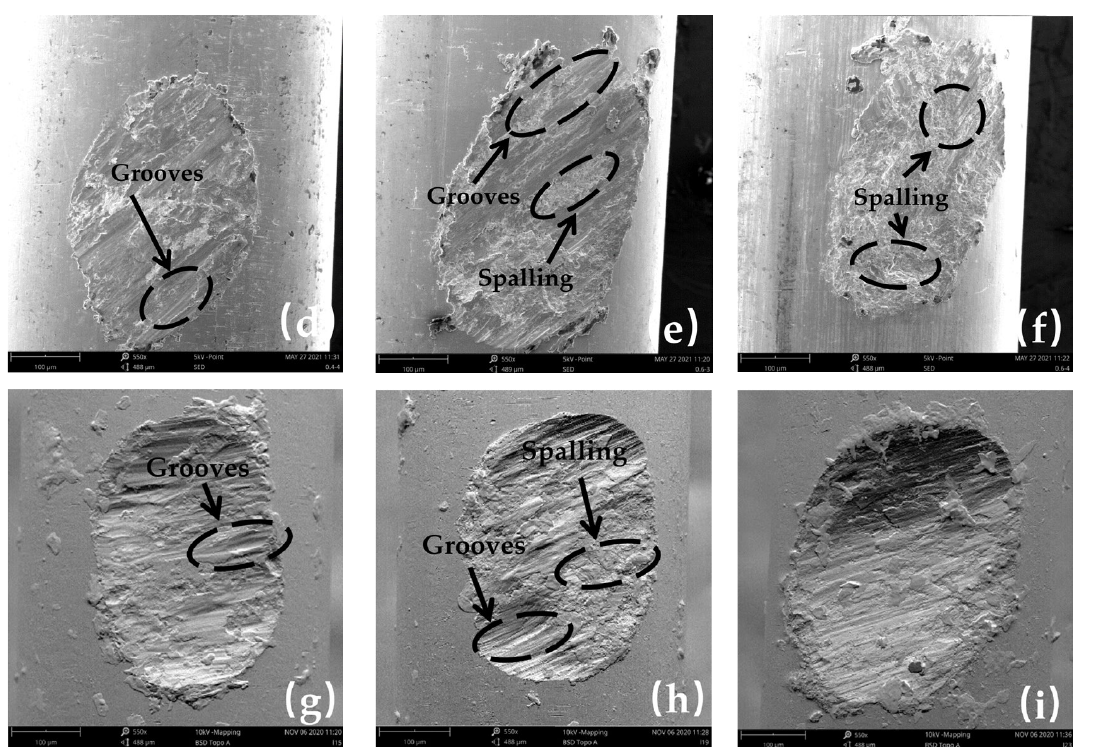
Figure 8. SEM images of worn surface under different strokes and temperatures: ( a ) 20 °C—0.4 mm; ( b ) 200 °C—0.4 mm; ( c ) 400 °C—0.4 mm; ( d ) 20 °C—0.6 mm; ( e ) 200 °C—0.6 mm; ( f ) 400 °C—0.6 mm; ( g ) 20 °C—0.8 mm; ( h ) 200 °C—0.8 mm;( i ) 400 °C—0.8 mm.